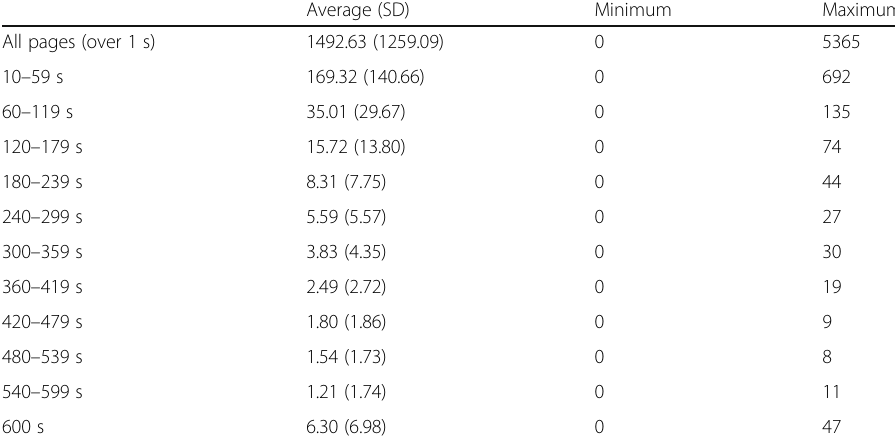
Table 3 The descriptive data of the pages that learners read Average (SD) Minimum Maximum All pages (over 1 s) 1492.63